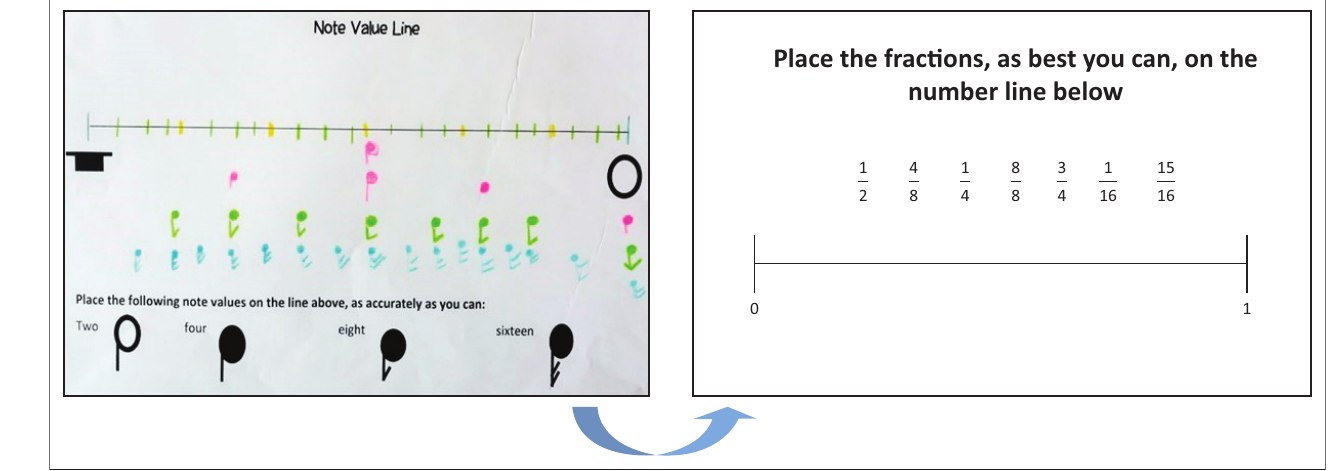
FIGURE 6: Example of how the ‘note value line’ was used along with the number line between zero and one.